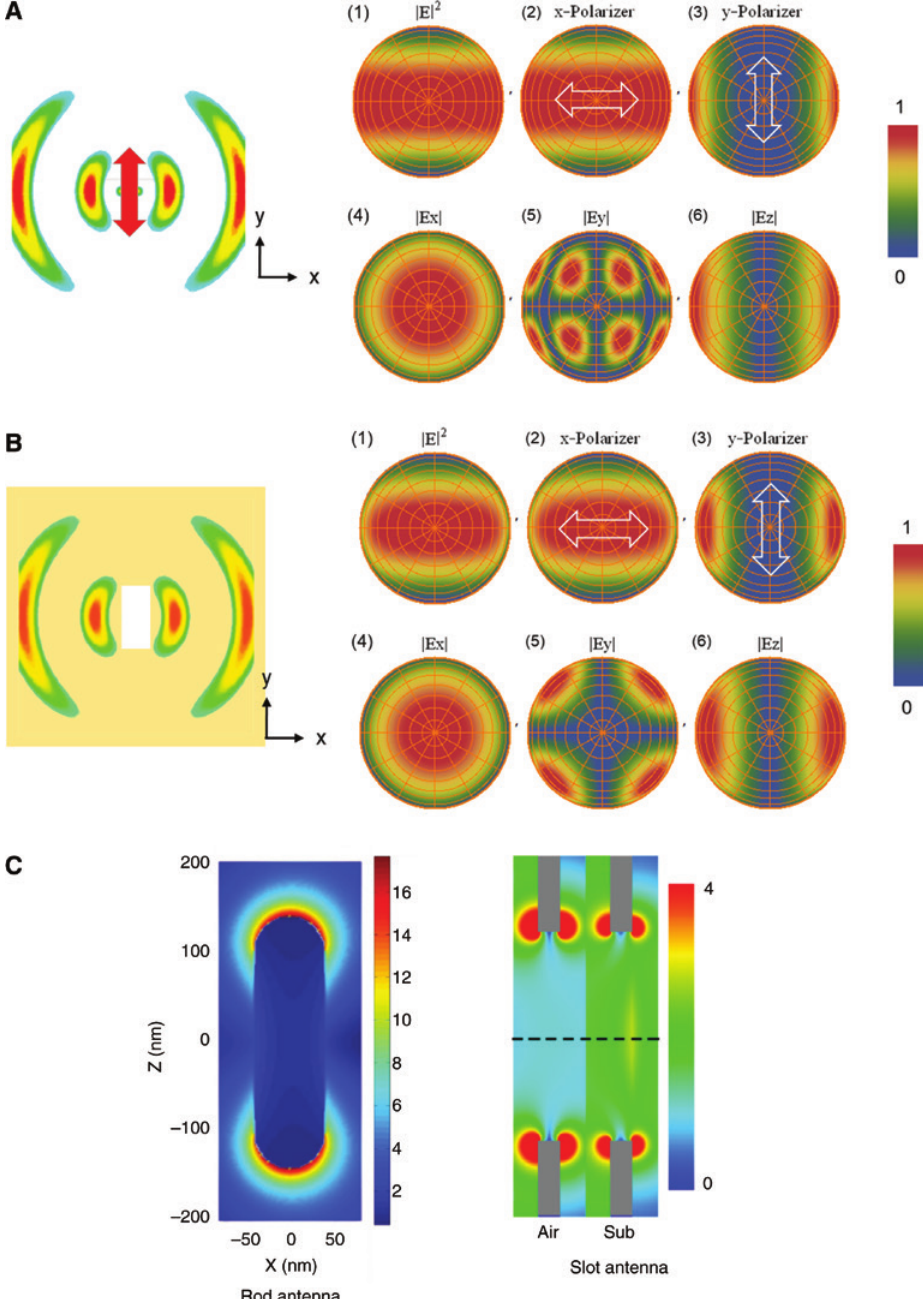
Figure 7: Equivalence of a metallic nanoslot and a magnetic dipole. (A) Simulated electric near-field of a virtual magnetic dipole at 660 nm wavelength (left). Far-fields transformed from near field (right). (B) Simulated electric near-field of the Ag metal slot at 660 nm wavelength (left). Far-fields transformed from near field (right). The white arrows indicate the polarization of the detectors, and each plot is normalized. (C) Simulated E-field intensity of an optical rod antenna (left) and H-field intensity of an optical slot antenna (right). (C) Reprinted with permission from Ref. [42]. Copyright 2008 Wiley. and Ref. [43]. Copyright 2009 Optical Society of